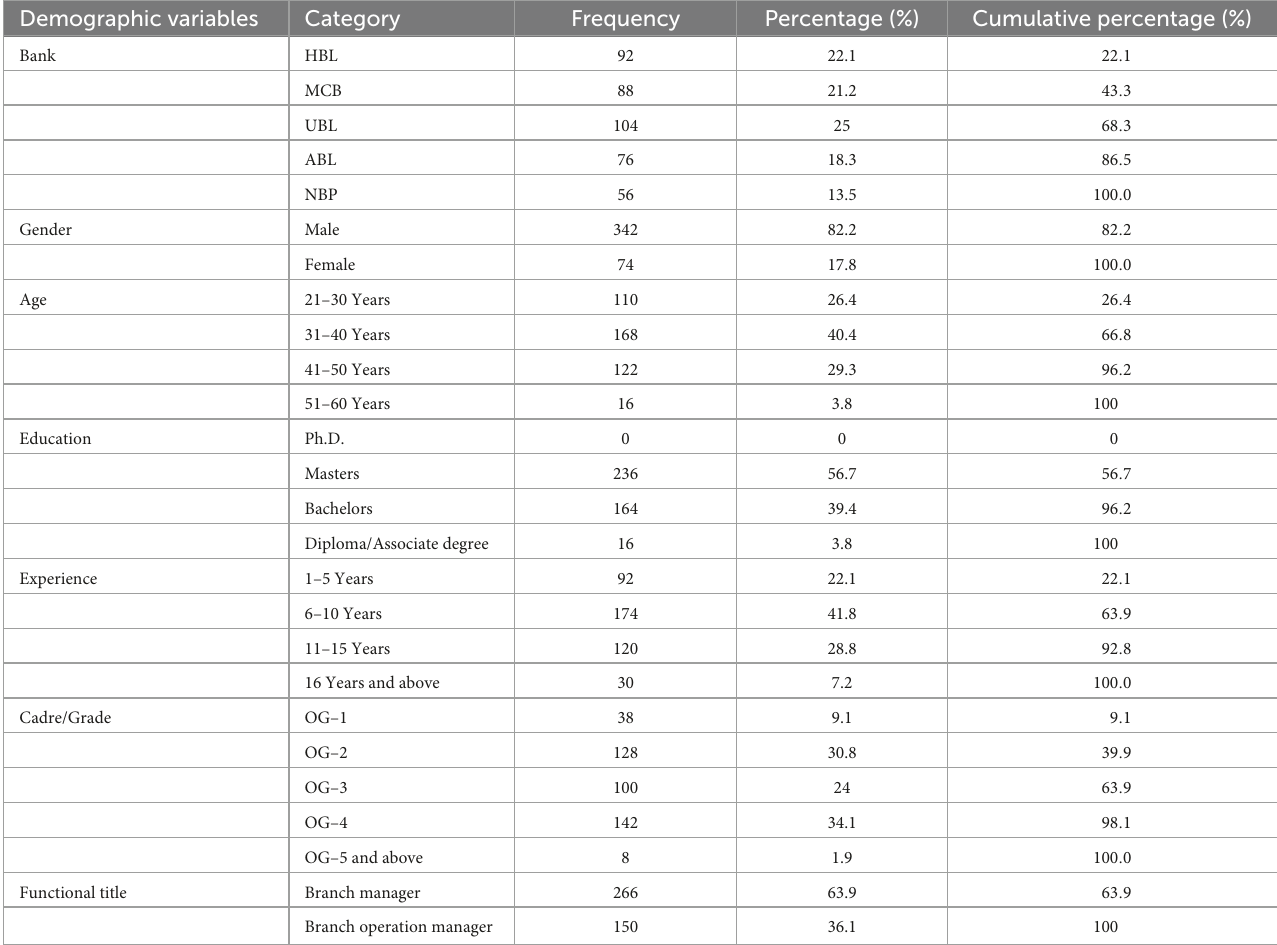
TABLE 1 Descriptive analysis of demographic